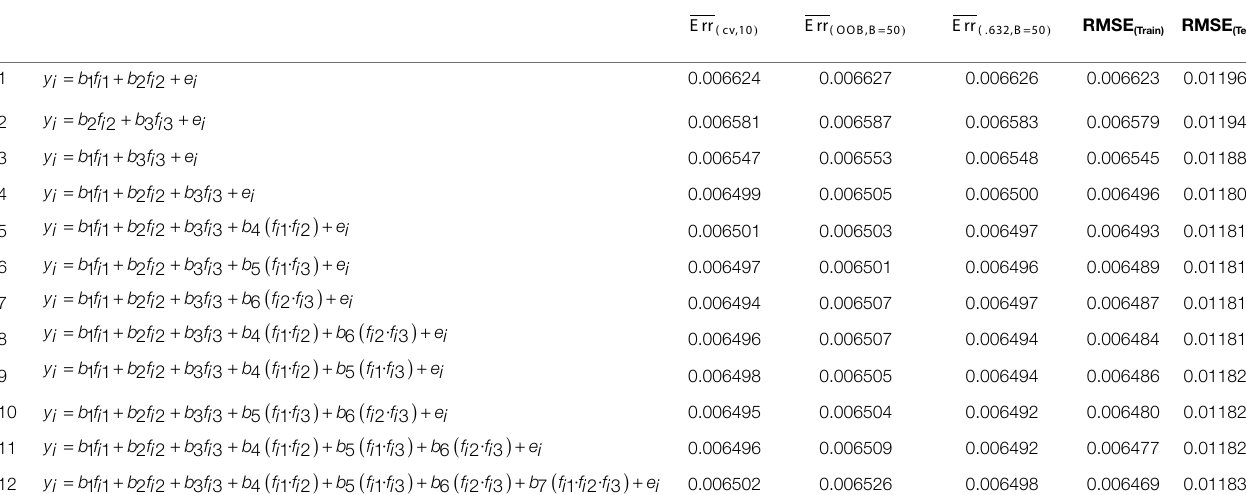
TABLE 2 | Out-of-sample model performance metrics for the nicotine dependence ERA model using NSDUH